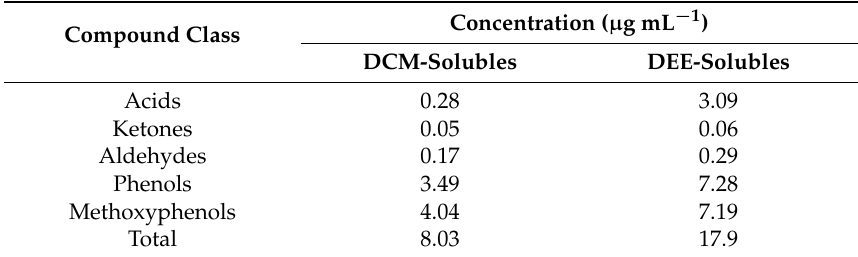
Table A2. Comparison of GC-FID quantification between DCM and DEE-soluble compounds in BC1 (experiment carried out at 300 ◦ C, 10 min, 10% with Procedure